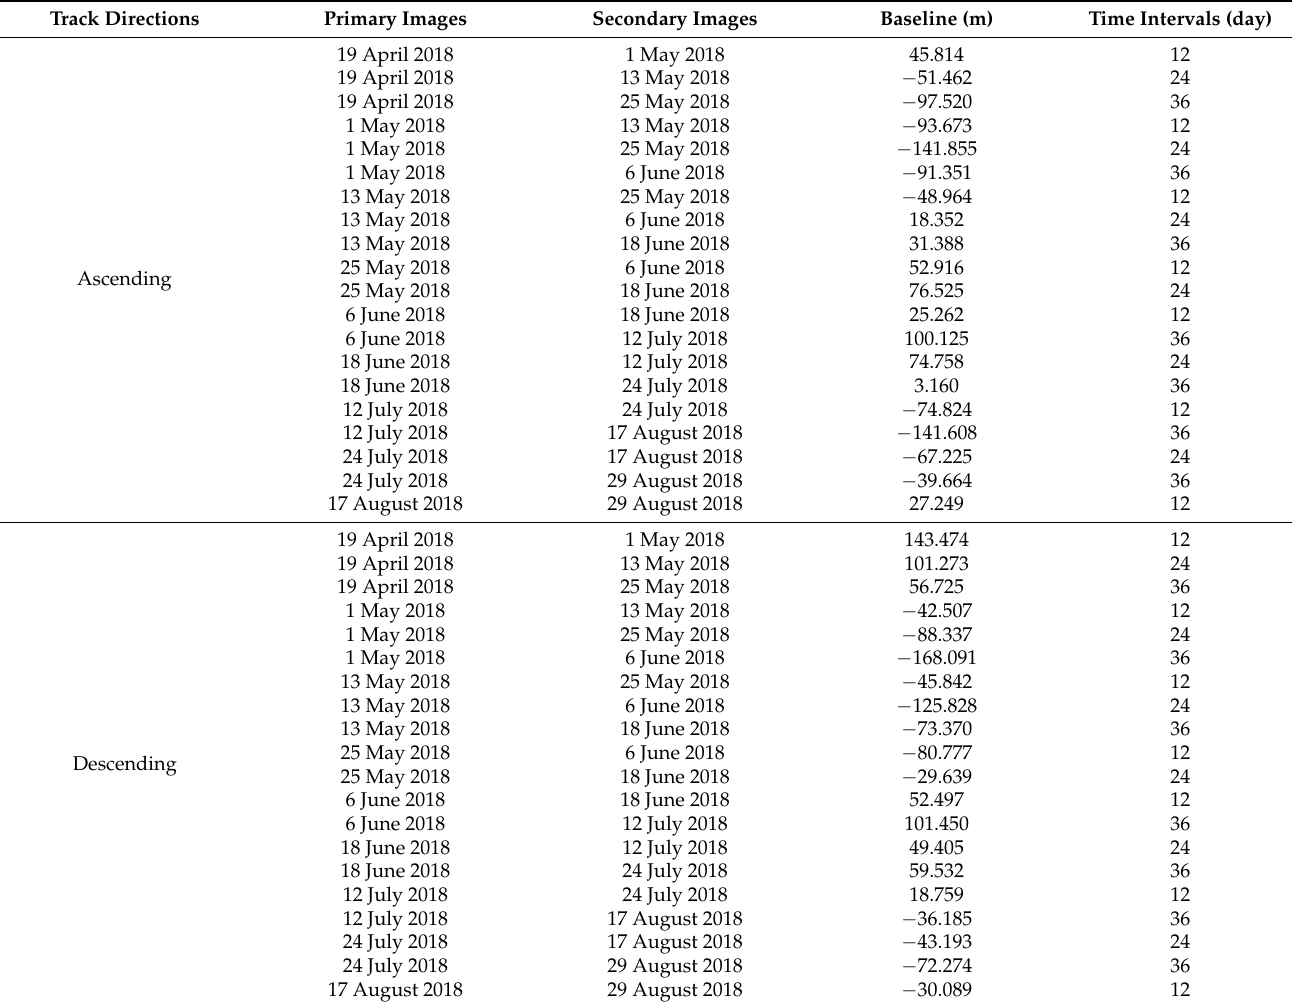
Table A2. Sentinel-1 image pairs used on Urumqi Glacier No.